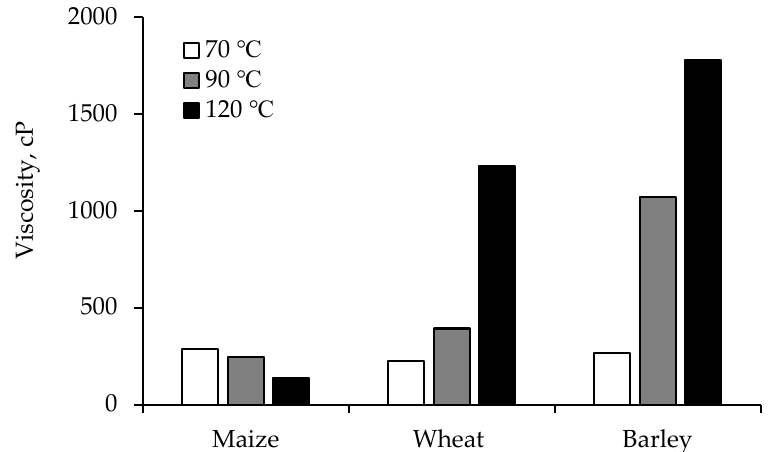
Figure 5. Differences in the viscosity of diets based on wheat, barley and maize under different heat-processing conditions. The data were collected at Schothorst Feed Research B.V. (Lelystad, The Netherlands). The respective diets consisted of 60% maize, 60% wheat or 60% barley, and they were pelleted at 70 °C, pelleted at 90 °C or expander pelleted at 120 °C. Viscosity was measured after 15 min according to the method developed by Bedford and Classen [177].